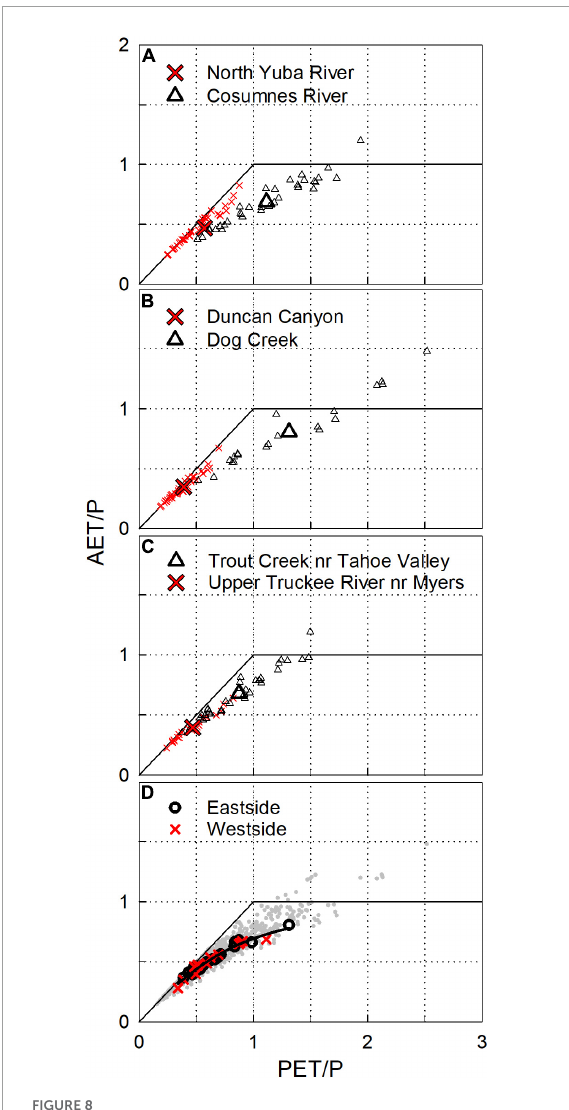
FIGURE8 Budyko diagrams, precipitation-normalized potential evapotranspiration ( PET/P ) versus precipitation-normalized actual evapotranspiration ( AET/P ). (A–C) Mean and annual values as large and small symbols, respectively. (D) All mean (bold symbols) and annual values (gray dots) for gaged watersheds in this study. The best fit line for mean watershed values in (D) is AET/P = 1 + PET/P – (1 + (PET/P)ˆb)ˆ(1/b) where b = 2.5928 (R-squared =